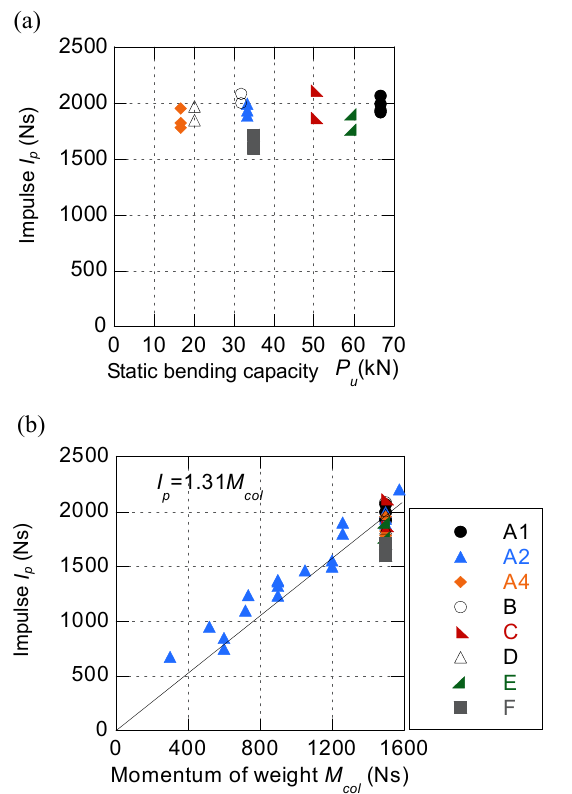
Figure 8. Relationship between the duration of impact force and static ultimate bending capacity, the ratio of the momentum of the weight at the time of collision (a) Static ultimate bending capacity (b) Ratio of momentum of weight to static ultimate bending capacity